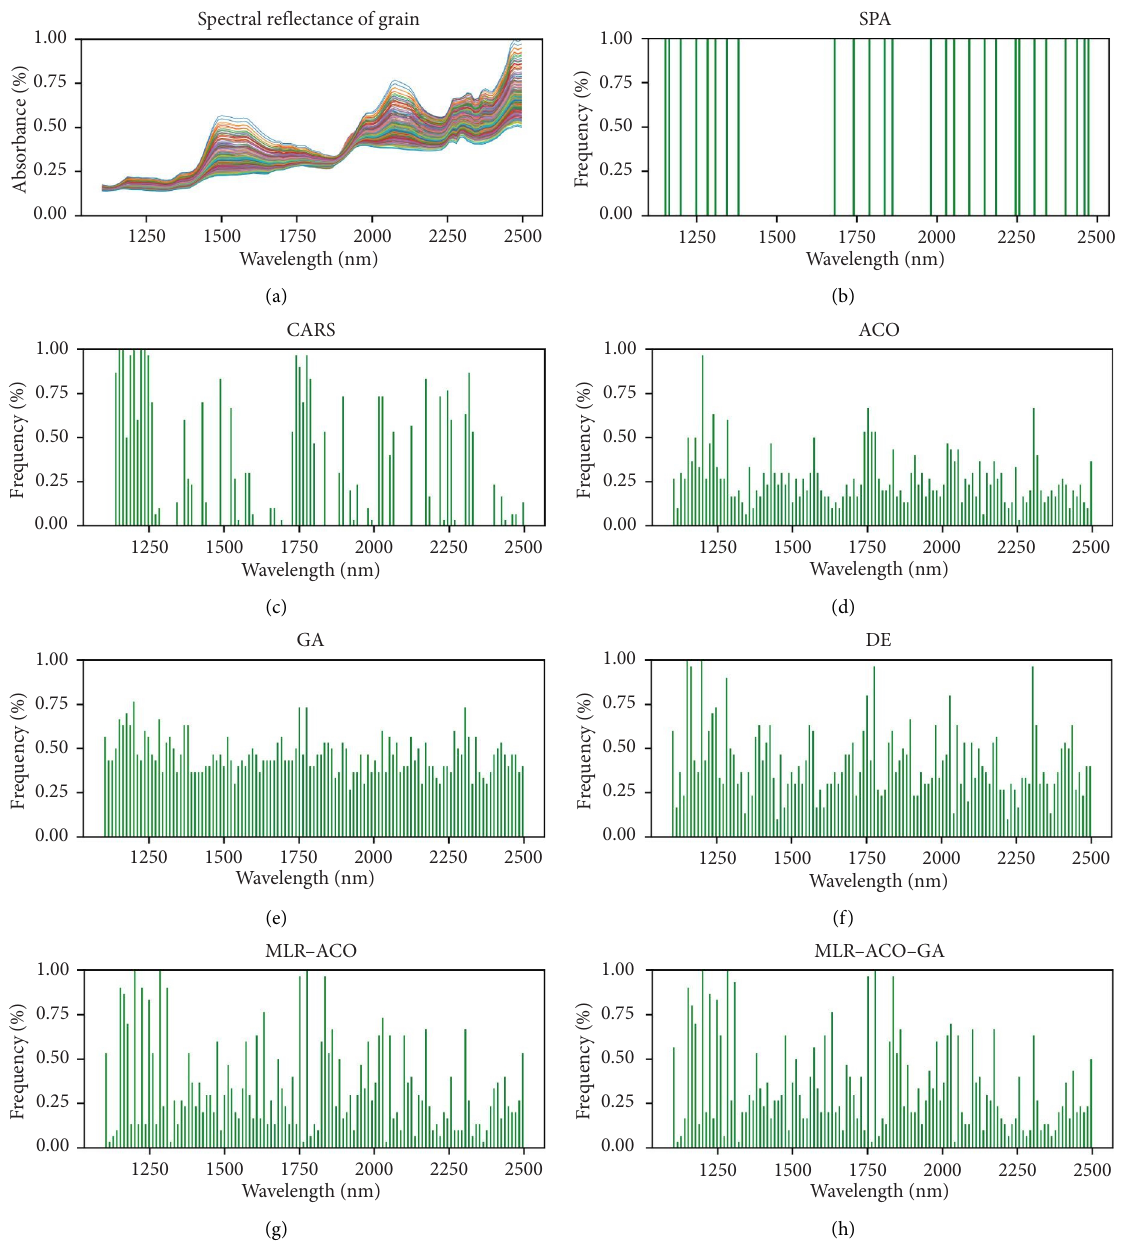
Figure 5: (a) Spectrograms of the grain dataset; (b–h) frequencies of variables selected by diferent wavelength selection methods on the grain dataset. (b) SPA, (c) CARS, (d) ACO, (e) GA, (f) DE. (g) MLR-ACO, and (h) MLR-ACO-GA.